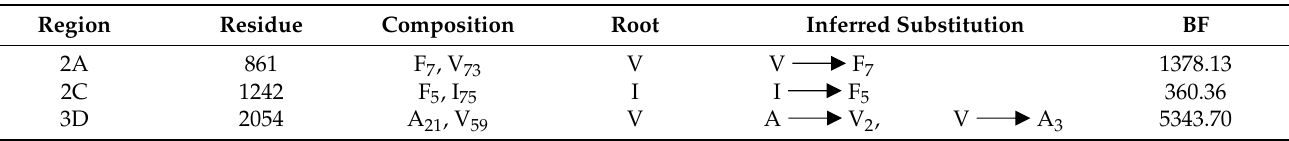
BF = Bayes Factor. Cut-off significance level was set at BF ≥ 100.